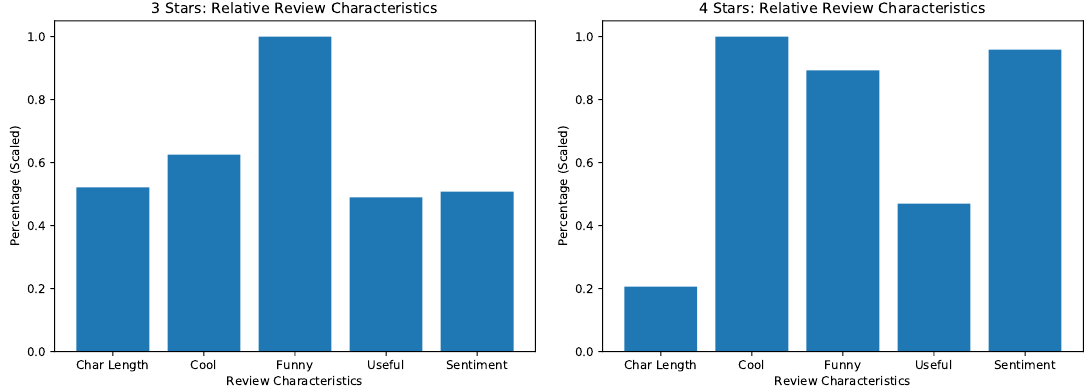
Figure A8. Results from analysis “Review Trends in Phoenix 2018”. Displayed are relative characteristics of 3 and 4 star reviews over reviews of restaurants in Phoenix